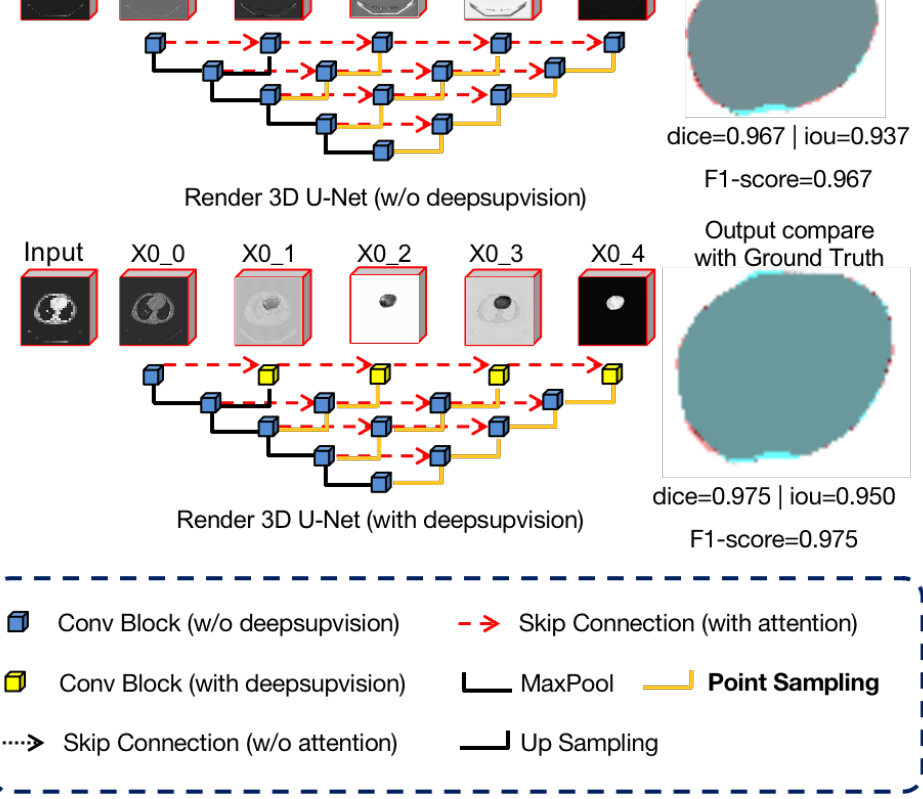
Figure 7. Visualization and comparison of feature maps along skip connections for heart CT images: note that the red area denotes the ground truth and that the blue area denotes the segmentation